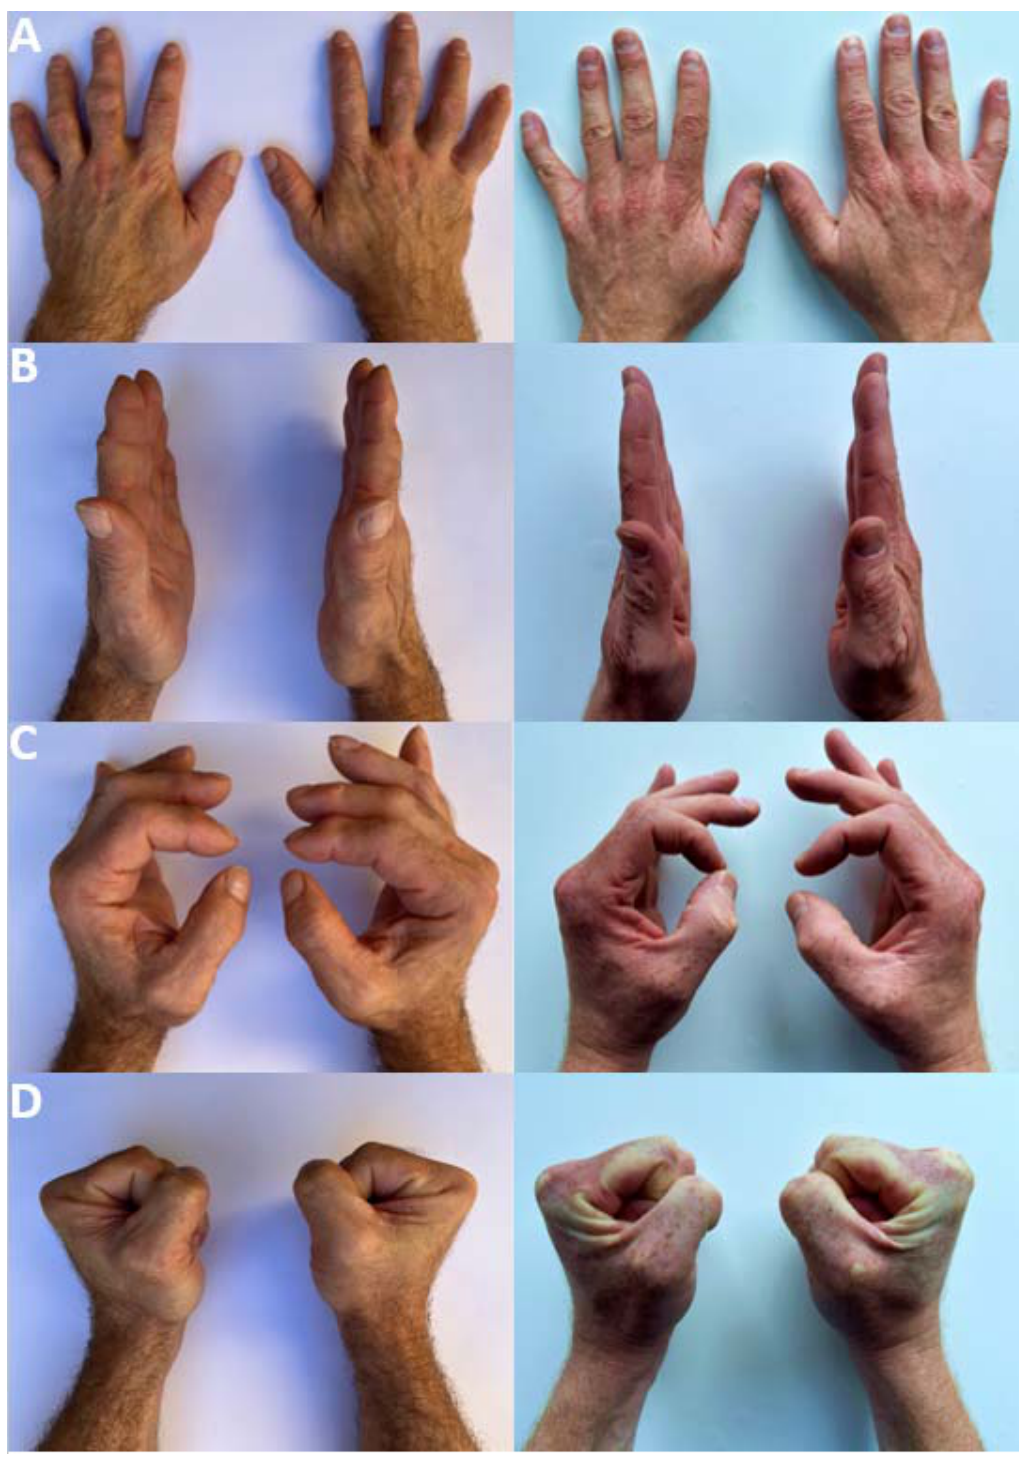
Figure 1. Clinical appearance of both hands of the climber (left) in contrast to hands of a non-climber (right). ( A ): View from dorsal. ( B ): View from radial with full finger extension. ( C ): View from radial with increasing finger extension for better radial view of the fingers. ( D ): View from radial with full finger flexion. Note the reduced finger flexion of the participant in contrast to the non-climber in ( D ).